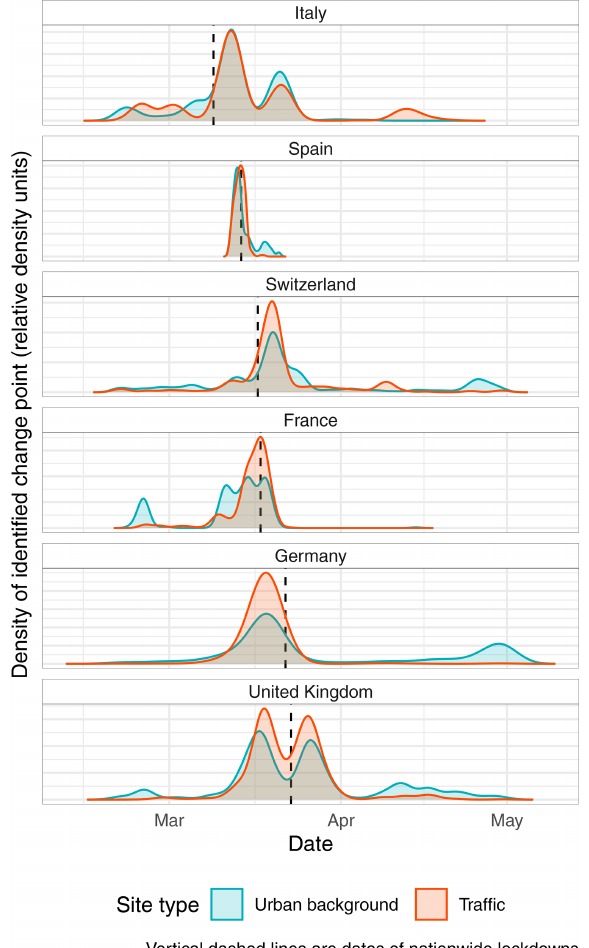
Figure 5. Estimated timing of changes to NO 2 concentrations for six European countries between March and May 2020. The distribu- tion shown for each country is the dimensionless probability distri- bution of the estimated change point in concentration. The country panels are ordered by nationwide lockdown